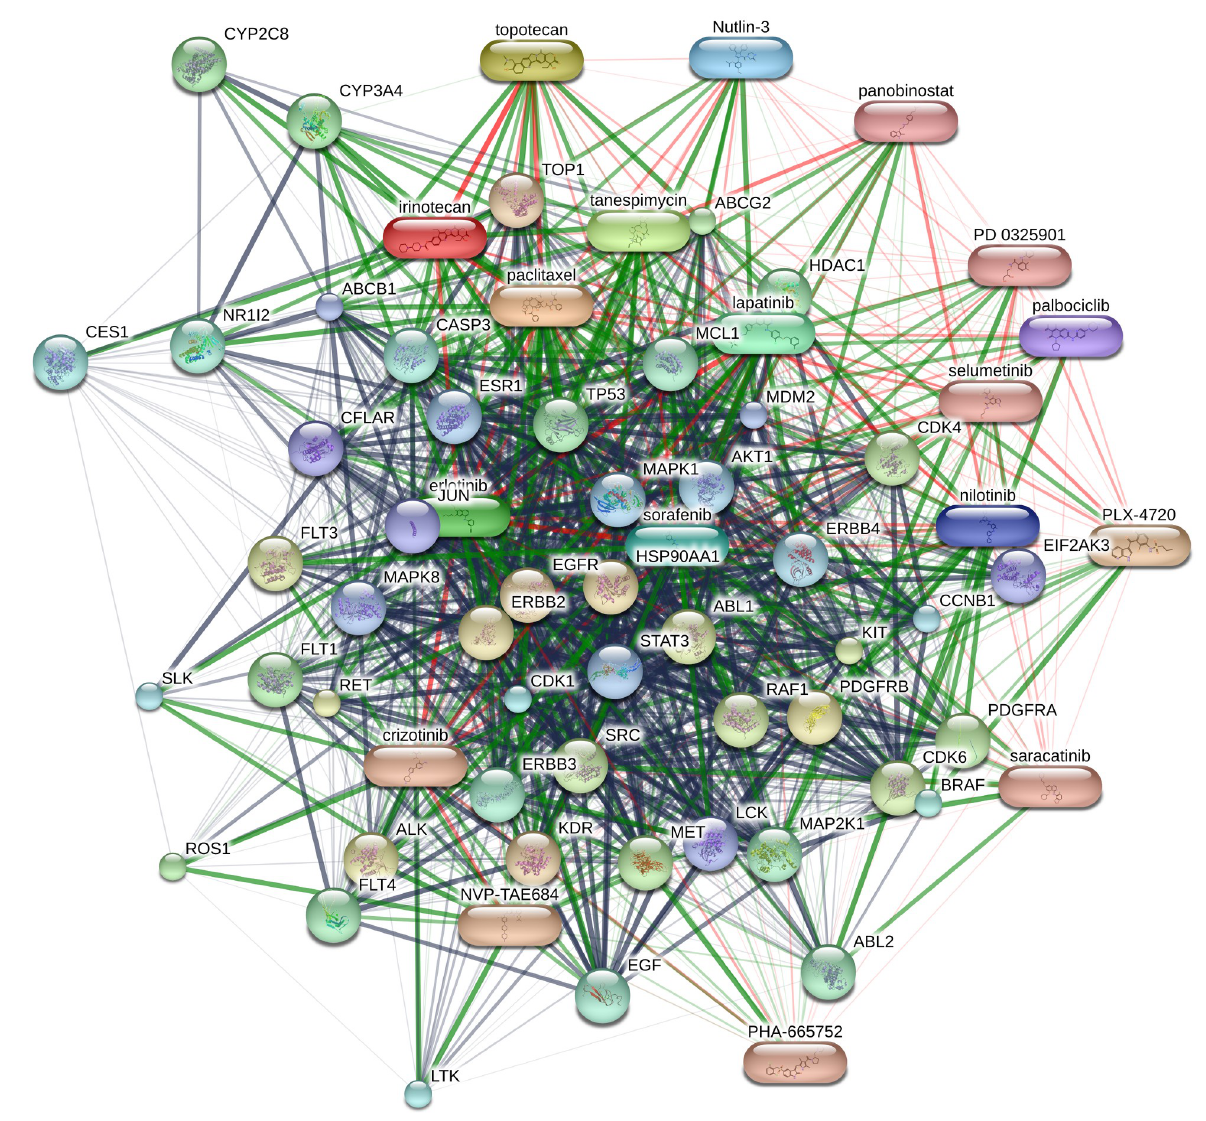
Fig 1. STiTCH network for drugs in